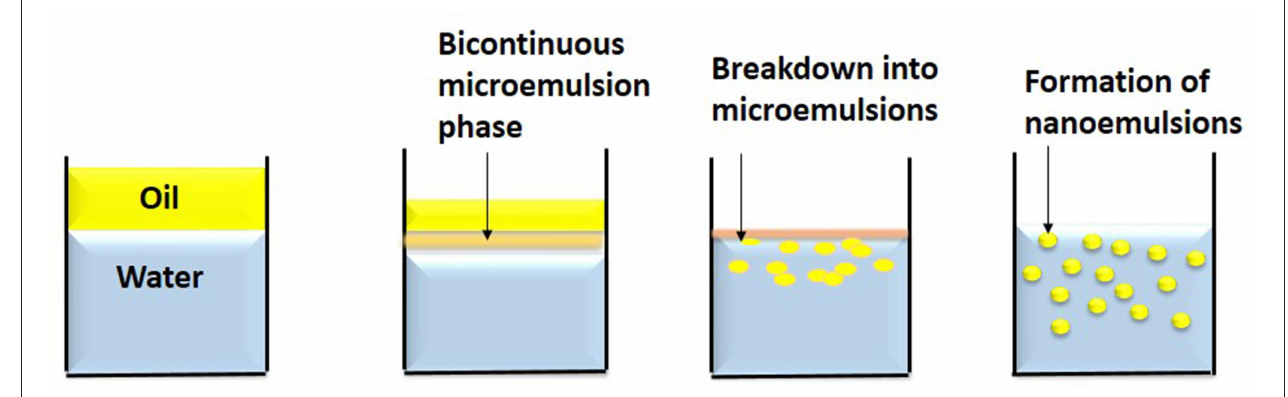
FIGURE 4 | Spontaneous emulsification is a low energy method. In this method, nanoemulsions are formed on mixing water and oil together with an emulsifier by gentle stirring at a particular